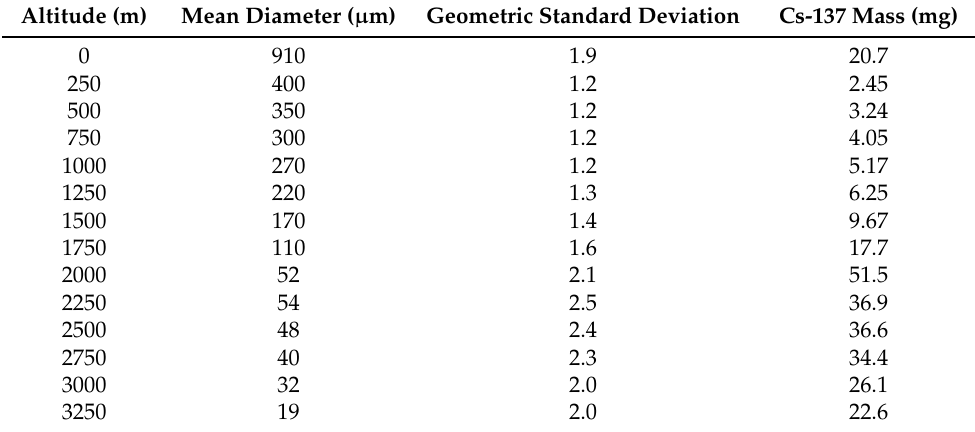
Table 1. Profile for elevated release.